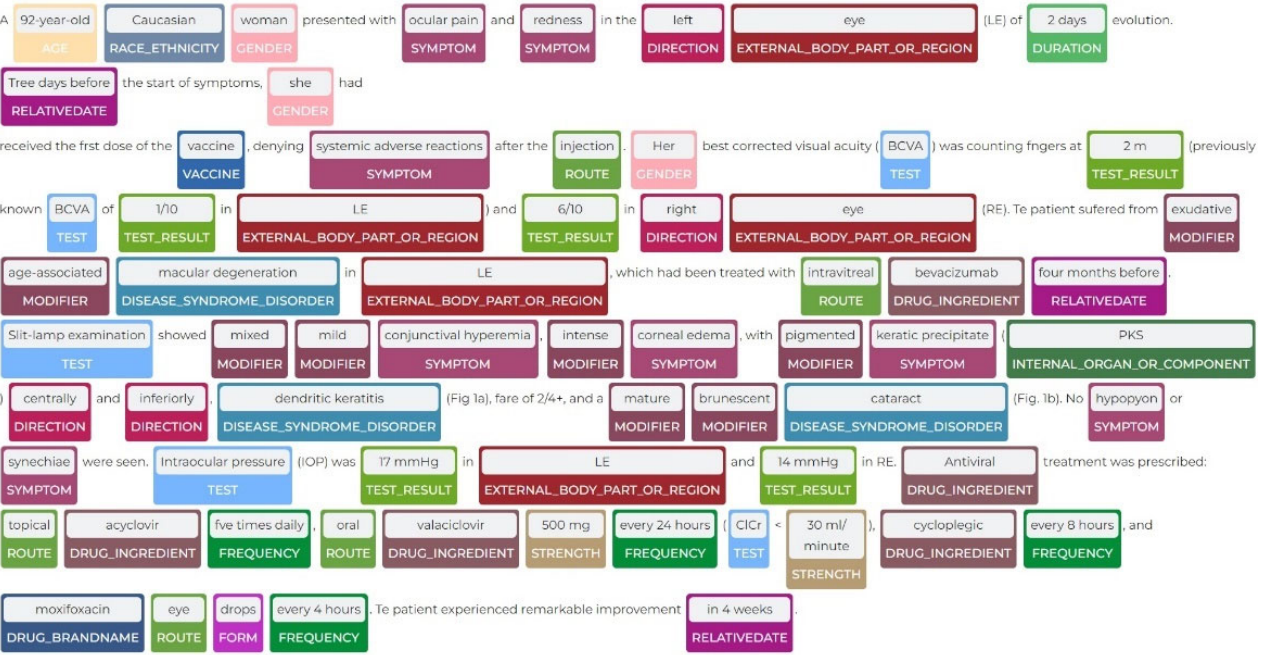
Figure 4. COVID ‐ 19 hospitalization by race and ethnicity.